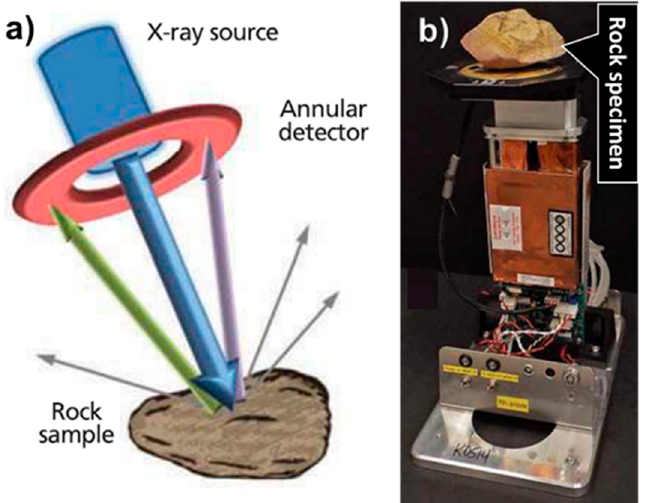
Figure 7. ( a ) Schematic diagram of a handheld back-reflection EDXRD technique, ( b ) photograph of the handheld back-reflection EDXRD system, reproduced from [82].